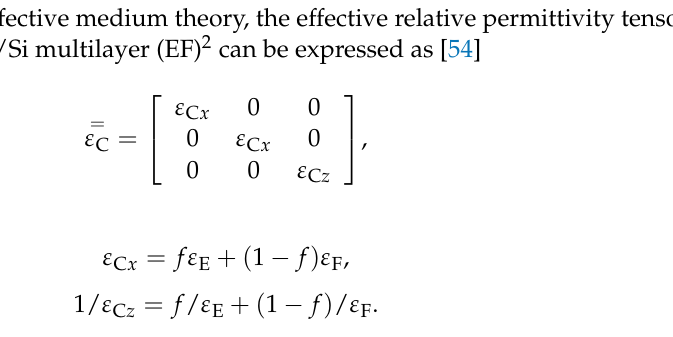
Figure 4. ( a ) Schematic of the 1-D PCCH [(EF) 2 D] 6 , where (EF) 2 represents the HMM and D represents the dielectric. ( b ) x and z components of the effective relative permittivity tensor of the subwavelength ITO/Si multilayer (EF) 2 as a function of the wavelength. The purple shadow region represents the type-I HMM region.